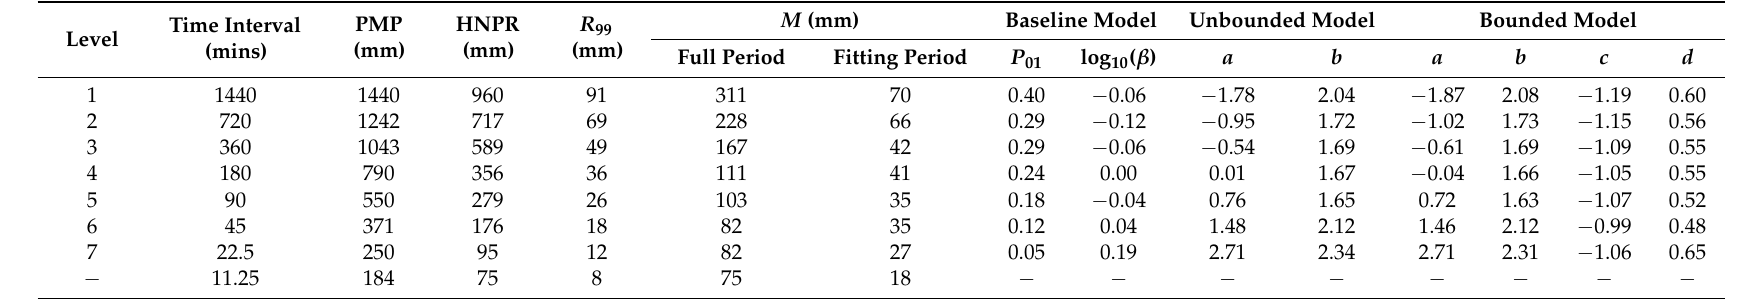
Table 3. Data properties and estimated parameter